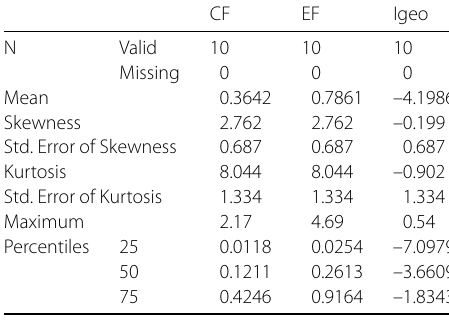
Table 10 Calculations of descriptive statistics of water pollution indices